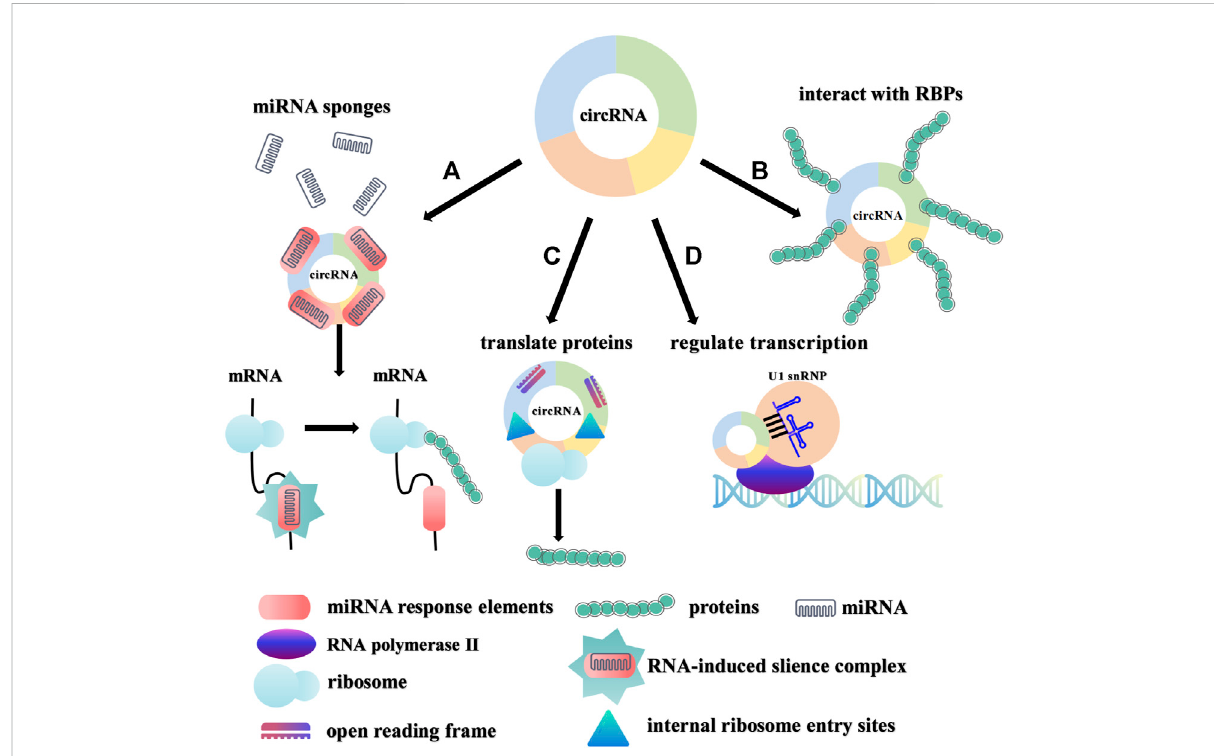
FIGURE 3 Biological functions of circRNAs. (A) . miRNA sponges. circRNAs can function as miRNA sponges to regulate the expression of target genes. (B) . InteractionwithRBPs.circRNAscaninteractwithRBPstoaffectdownstreamsignals. (C) .Proteincoding.circRNAswithIRESsandORFscantranslate certain proteins/peptides to perform special functions. (D) . Transcriptional regulation. EIciRNAs and U1 small nuclear ribonucleic proteins (U1snRNPs)areco-localizedtothepromoteroftheparentalgeneandpromotetranscriptionoftheparentalgenewiththeparticipationofRNA polymerase